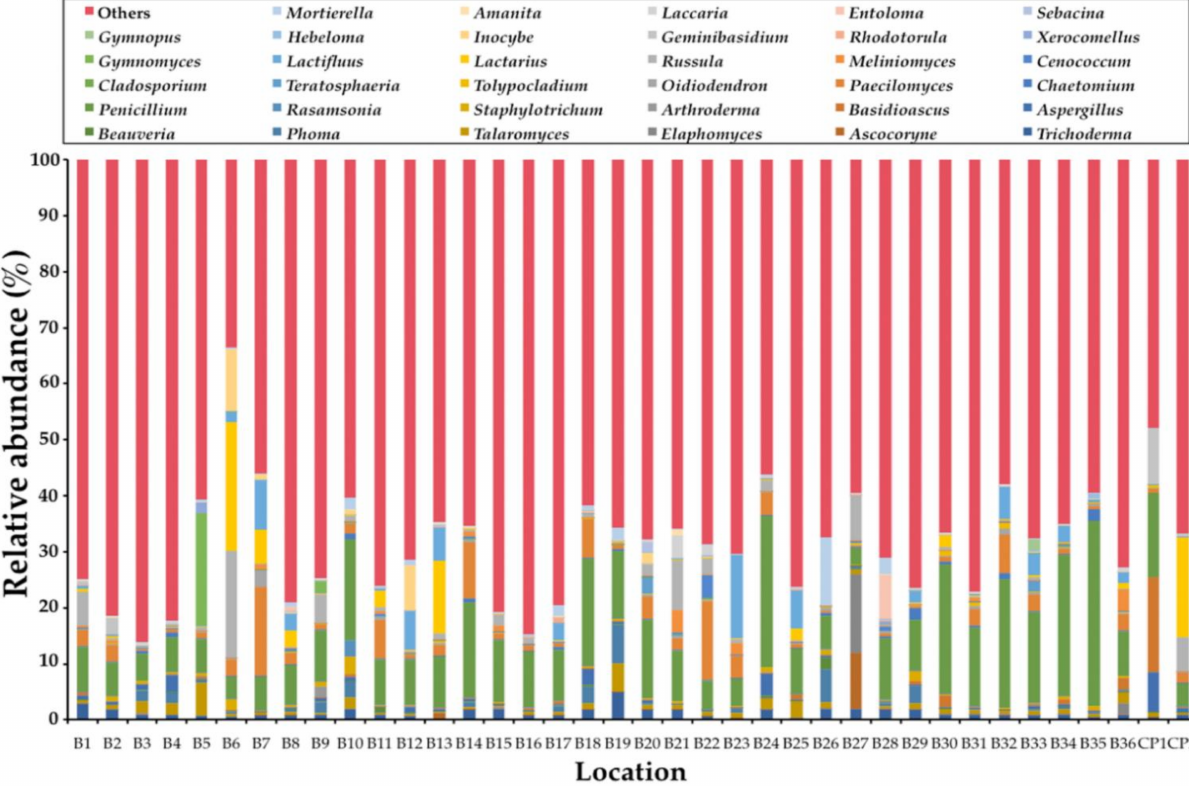
Figure 3. Soil fungal composition of each sample with the dominant of 35 fungal